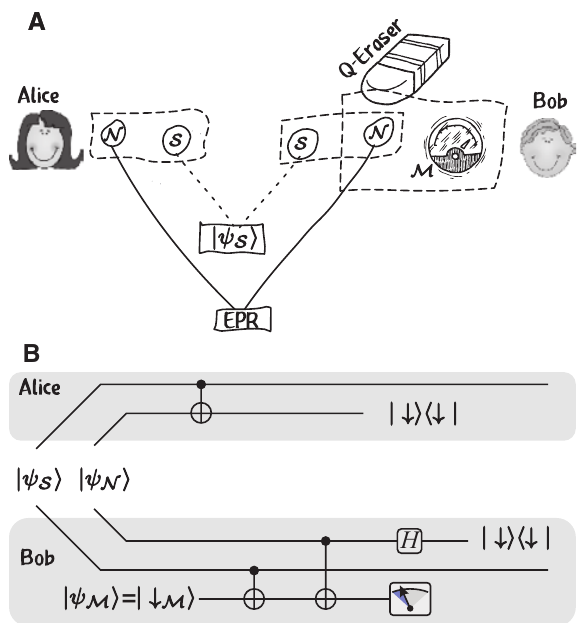
Figure 1: Nonlocal measurement via quantum